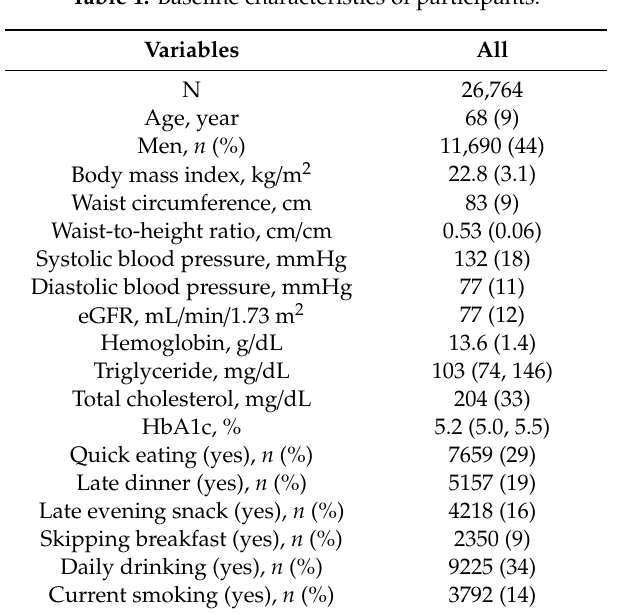
Figure 1. Flow diagram of the study. Baseline variables included unhealthy dietary habits (late dinner, skipping breakfast, quick eating, and late evening snack), height, body weight, waist circumference, blood pressure, urine protein (dipstick measurement), serum creatinine, hemoglobin, triglyceride, total cholesterol, blood glucose, glycated hemoglobin (HbA1c), serum uric acid, daily drinking, current smoking, use of antihypertensive agents, and use of glucose-lowering medication. eGFR, estimated glomerular filtration rate. Table 1. Baseline characteristics of